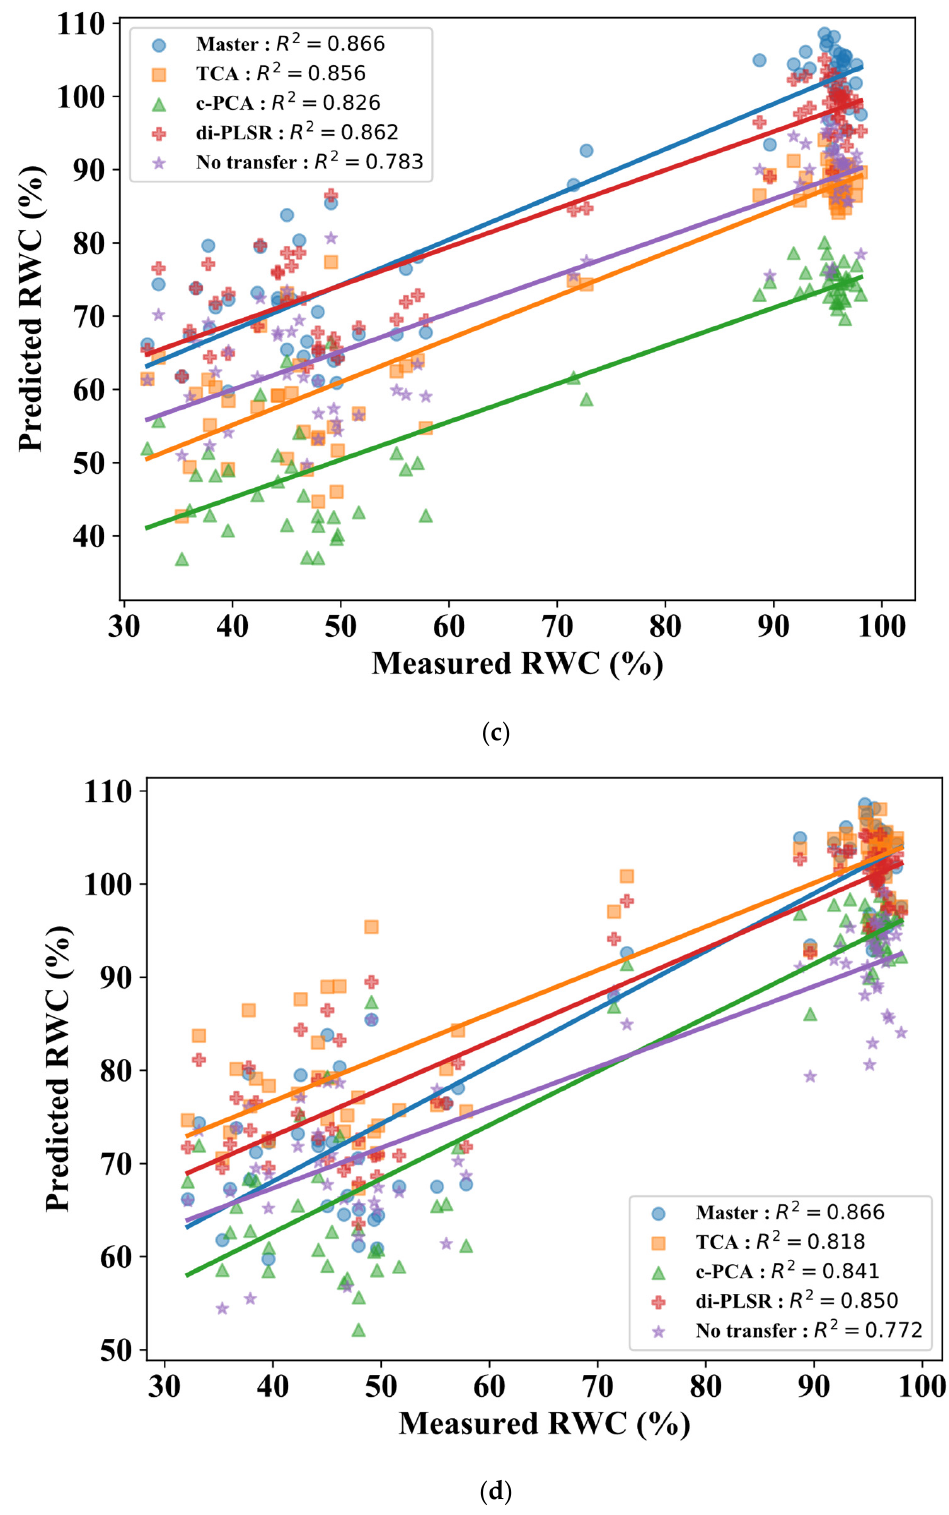
Figure 5. Measured and predicted RWC using TCA, c-PCA, and di-PLSR calibration transfer approaches: ( a ) slave–1 validation, ( b ) slave–2 validation, ( c ) slave–1 test, and ( d ) slave–2 test data. Predictions from master data are presented in blue circles, TCA in orange squares, c-PCA in green triangles, di-PLSR in red crosses, and no transfer in purple stars.